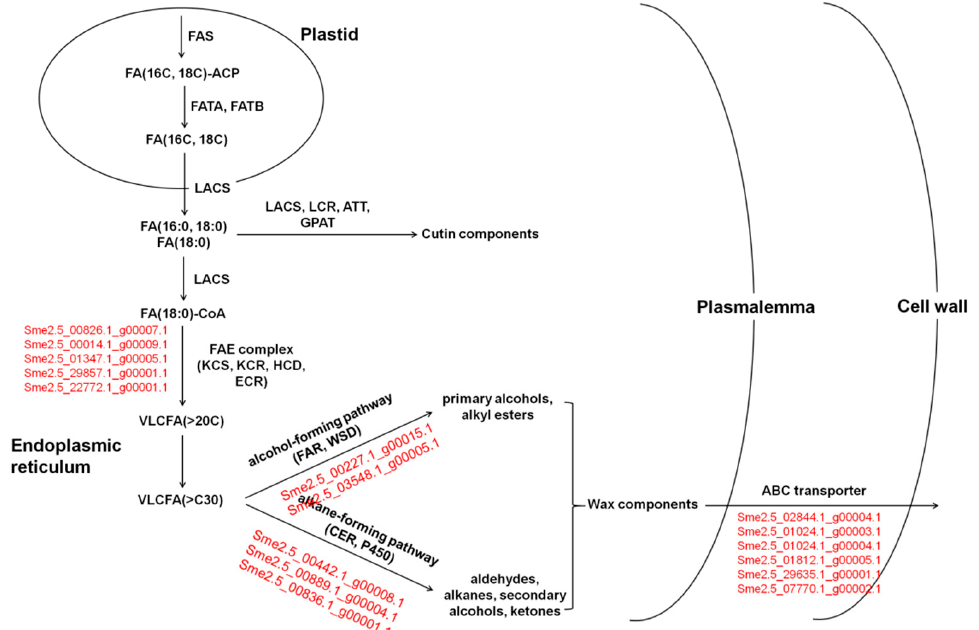
Figure 12. Hypothetical biosynthetic pathways for cutin monomers and wax constituents in fruit peel of eggplant. Genes with red color are candidate DEGs in hypothetical biosynthetic pathways.